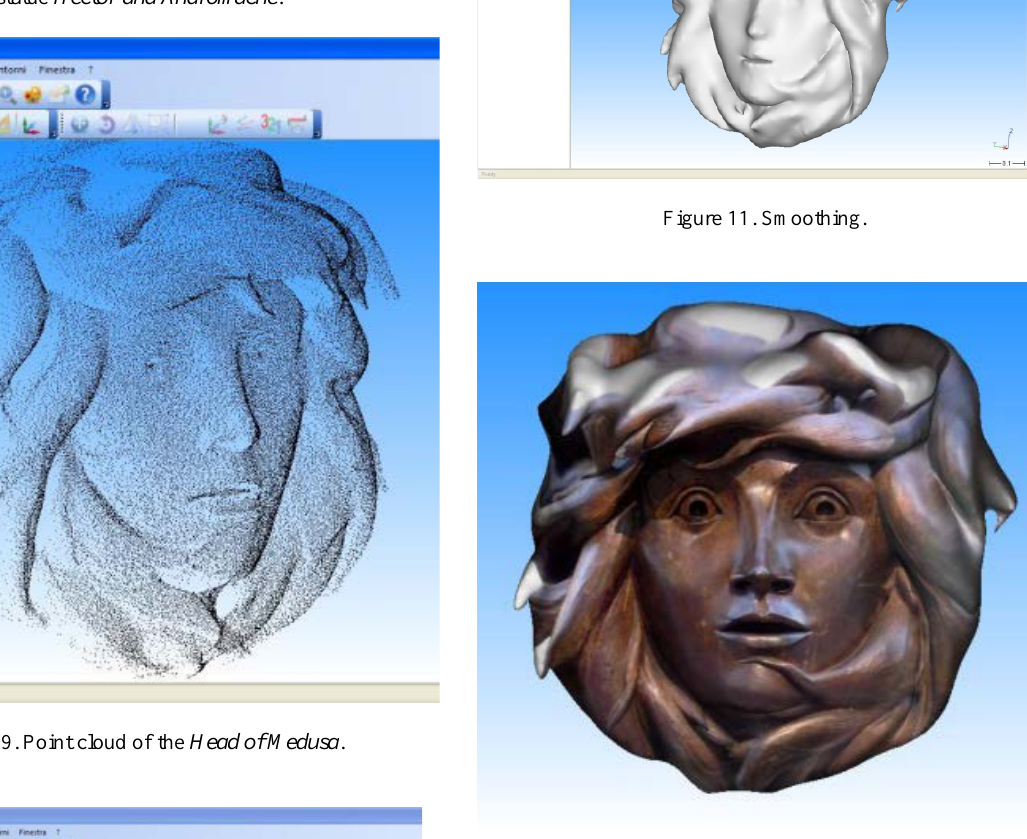
Figure 12.Texture Mapping.